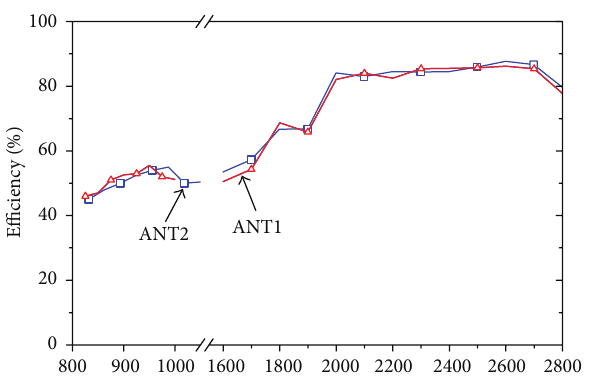
Figure 7: Measured efficiencies of the two array elements. Figure 8: Measured peak gains of the two array elements.